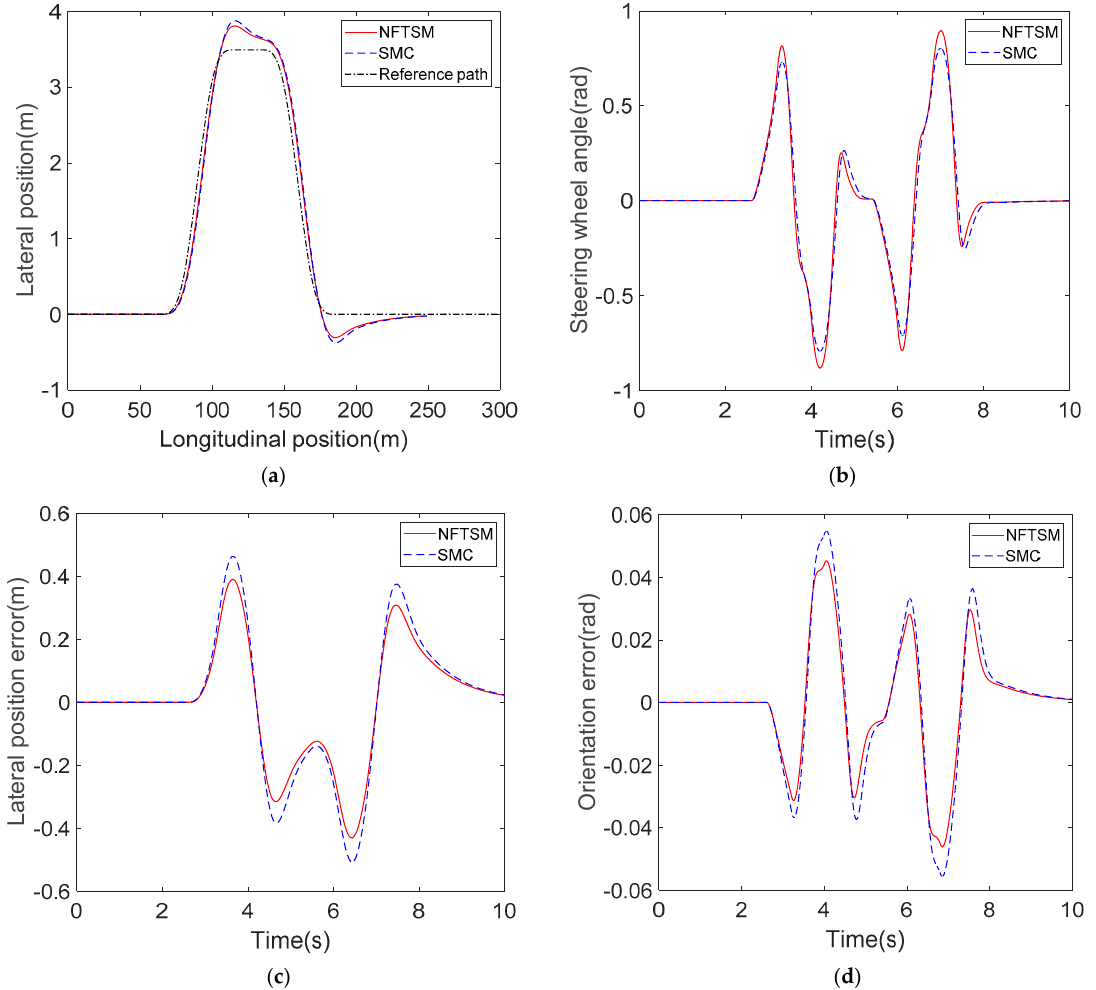
Figure 5. The simulation results for scenario 1: ( a ) Global vehicle trajectory; ( b )Steering wheel angle; ( c ) Lateral position error; ( d ) Orientation error.